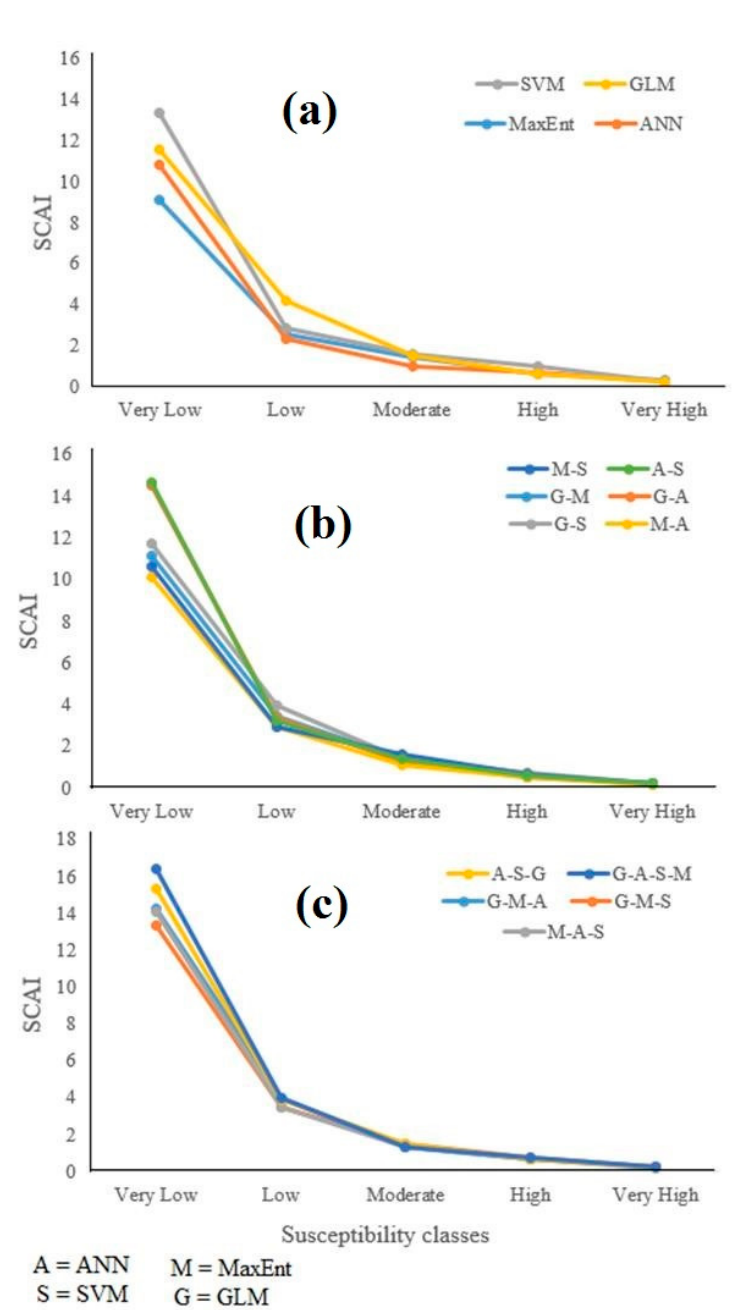
Figure 11. Seed cell area index (SCAI): ( a ) individual models, ( b ) two-model ensembles, and ( c ) three- and four-model ensembles.